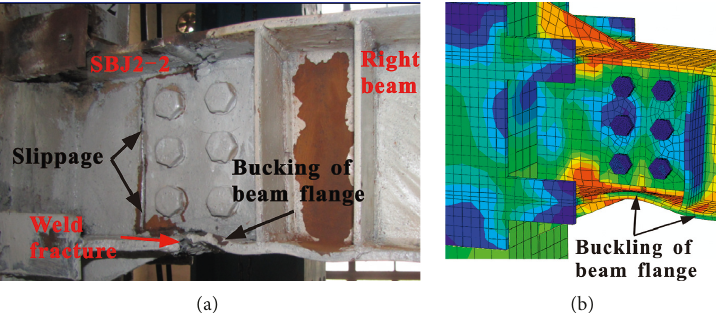
Figure 13: Comparison of the failure modes of the SBJ2-2 specimen determined by test and FEA. (a) Test. (b)